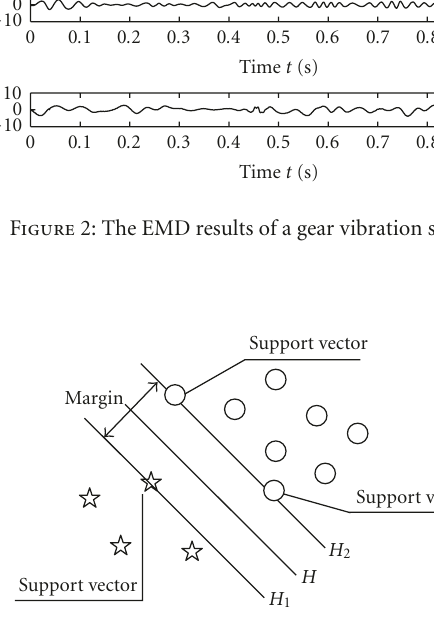
Figure 3: Classification of data by